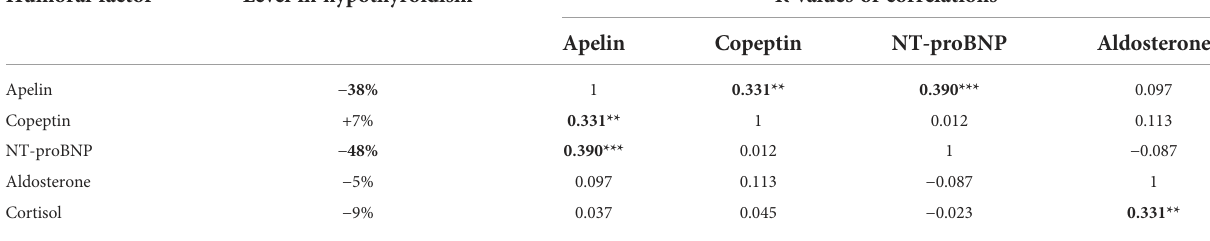
TABLE 3 Summary of relevant humoral factors for fl uid – ion homeostasis; changes in hypothyroidism compared to the corresponding levels after thyroid hormone replacement and their